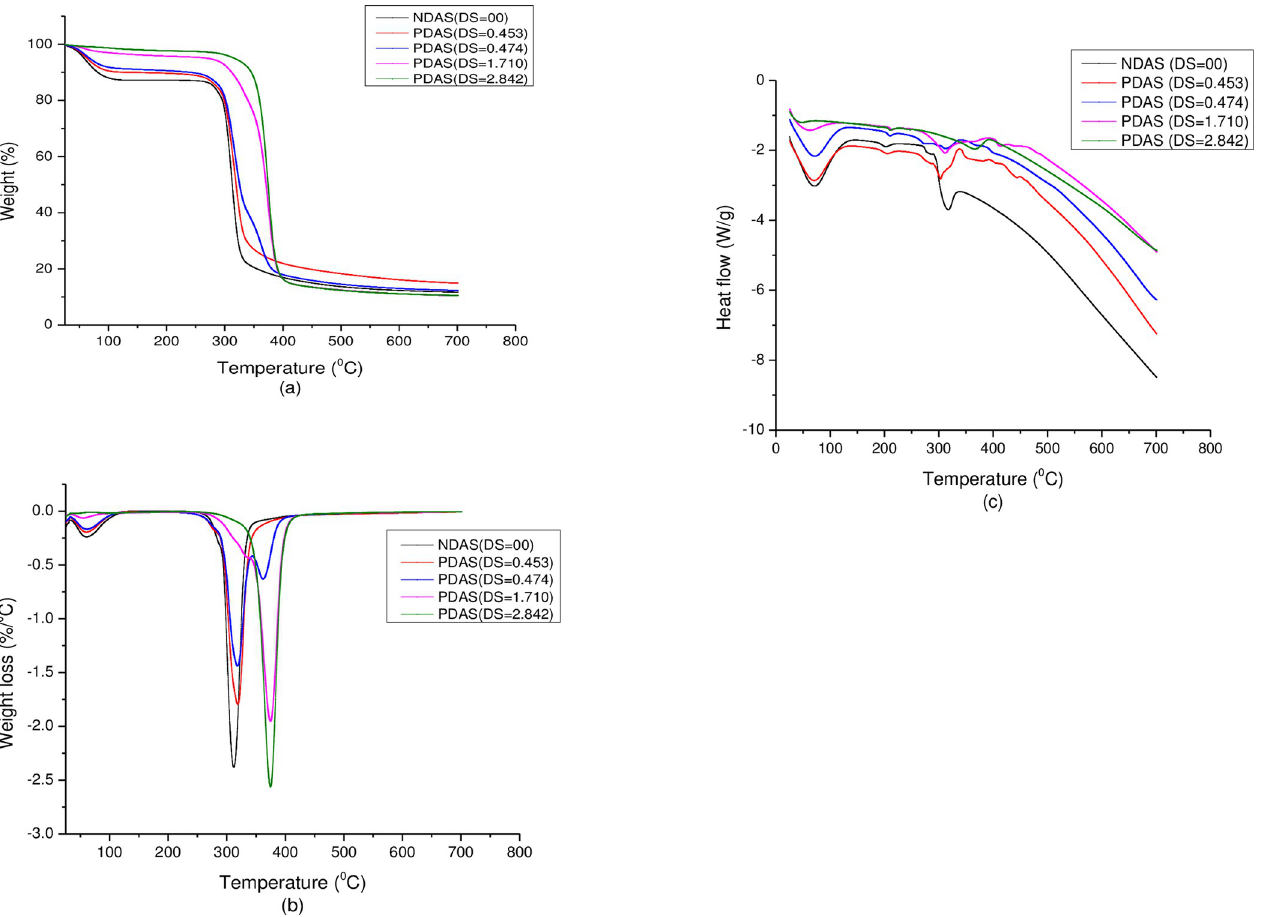
Fig 5. (a)TGA (b) DTG and (c) DSC thermograms of NDAS and PDAS with different DS (DS = 0.453, 0.474, 1.710 and 2.842).